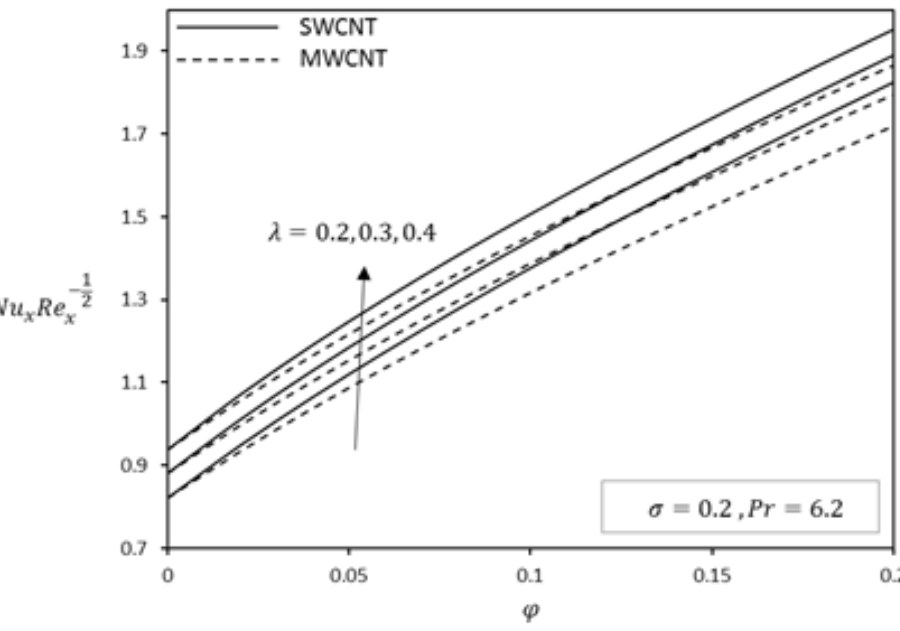
Figure 15. Effect of λ on Nusselt number for water-based fluid.